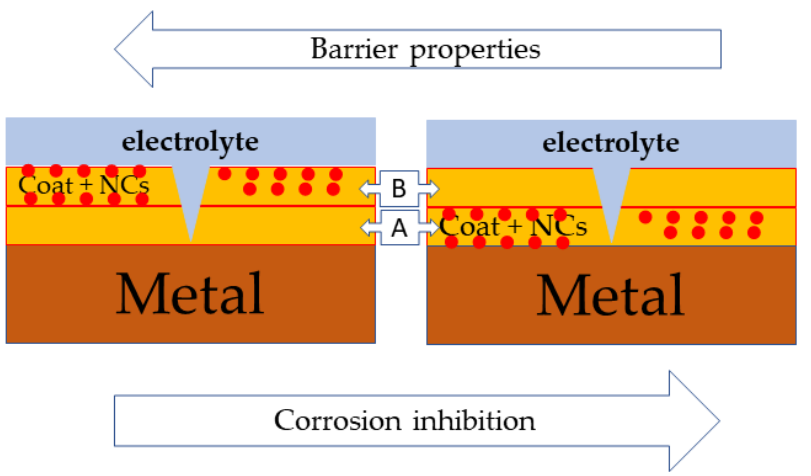
Figure 17. Two-layer coating of the same composition.